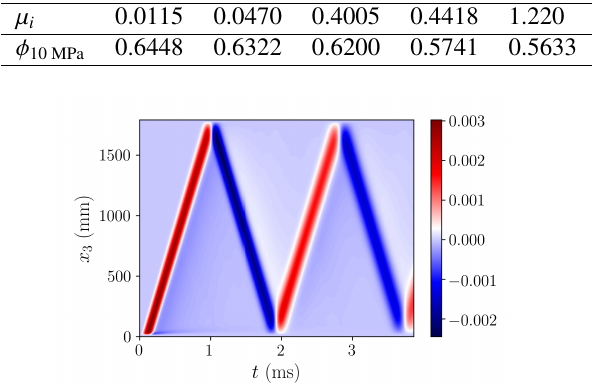
Figure 2: The space-time evolution of particle velocity in the longitudinal ( x ) direction for σ (cid:48) φ 10 MPa = 0 . 6322. The color code indicates the velocity component (m / s) in the longitudinal direction.